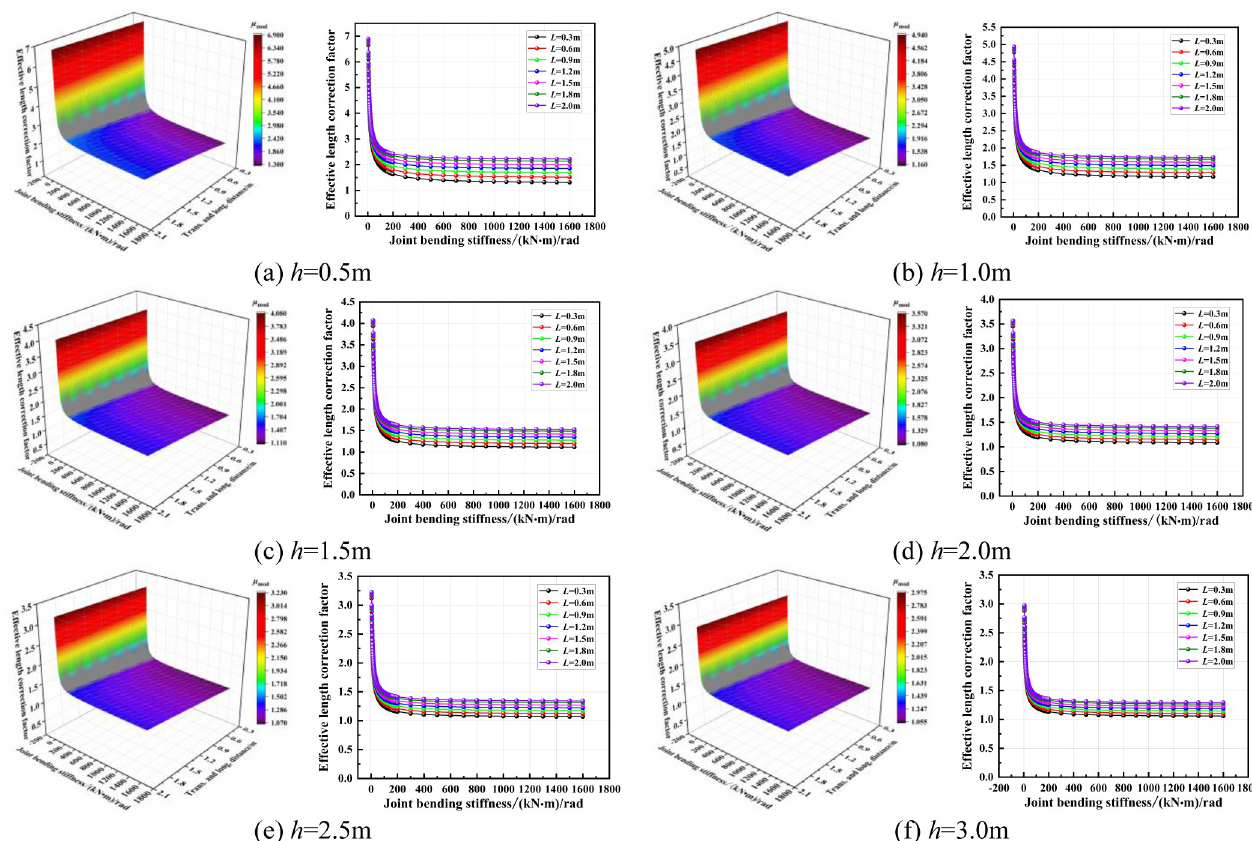
Fig 21. Three-dimensional diagrams of the influence of the joint bending stiffness on the effective length correction factor. (a) h = 0.5m. (b) h = 1.0m. (c) h = 1.5m. (d) h = 2.0m. (e) h = 2.5m. (f) h =